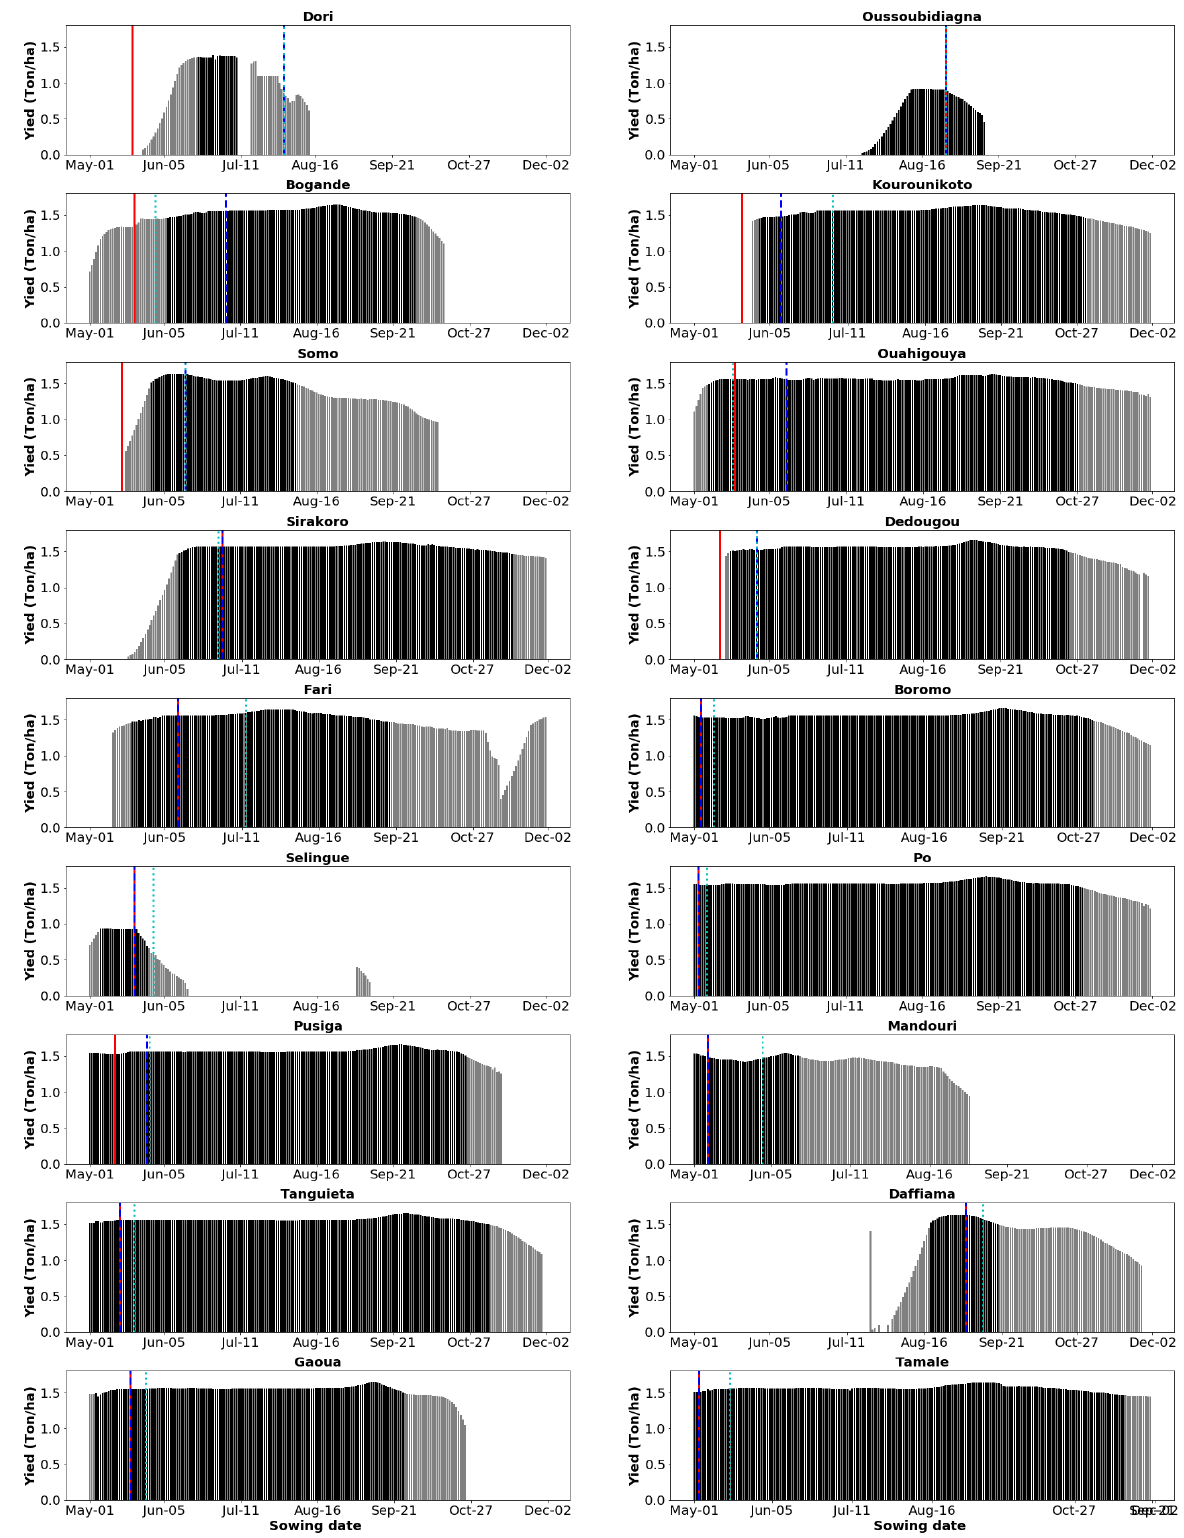
Figure A2. Variation of yield response to each date of the sowing window from 1st May to 31st November in 2019 expressed as bar chart for the available locations. The dark bars represent the safe windows and the vertical lines represent the different sowing based on the three definitions: (i) red for FP20mm, (ii) blue for LO20mm, and (iii) cyan for